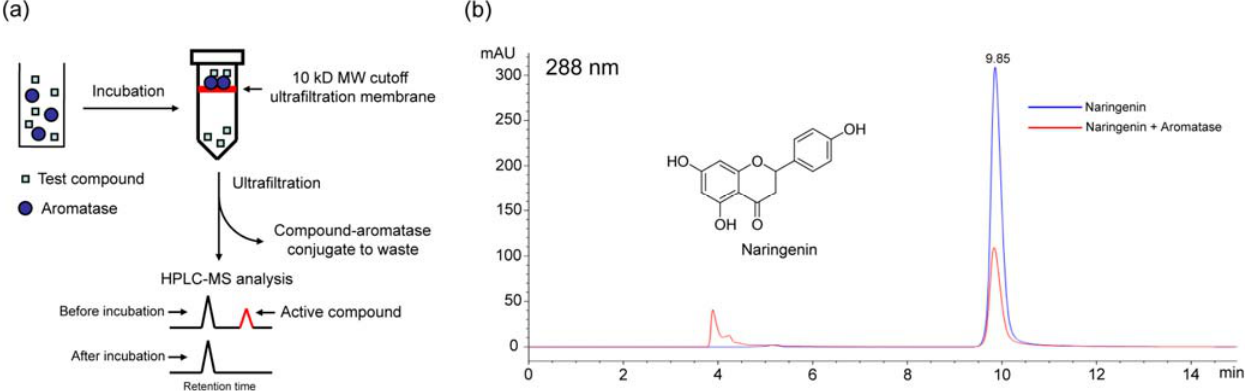
Figure 3. Ultrafiltration LC-MS screening for the aromatase binding activity of naringenin. (A) Schematic of the ultrafiltration LC-MS screening method. (B) HPLC chromatograms before (blue) and after (red) incubation of naringenin with aromatase.